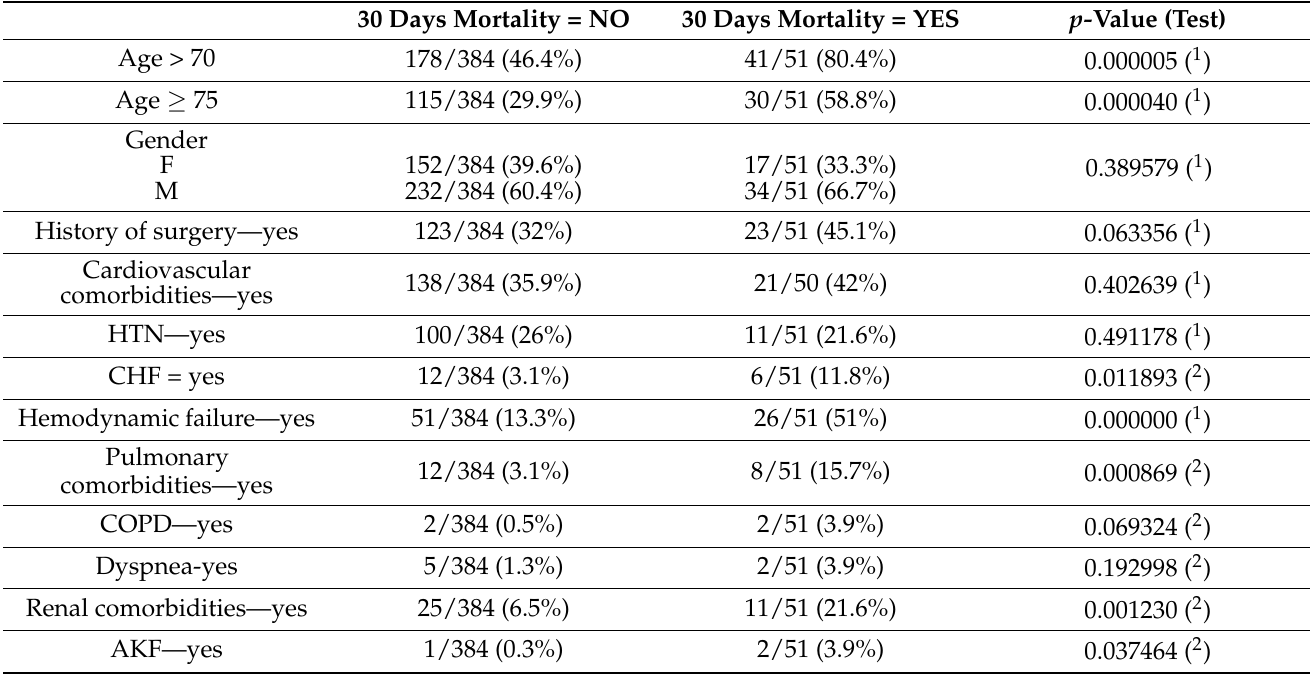
Table 1. Descriptive data and statistic association with postoperative